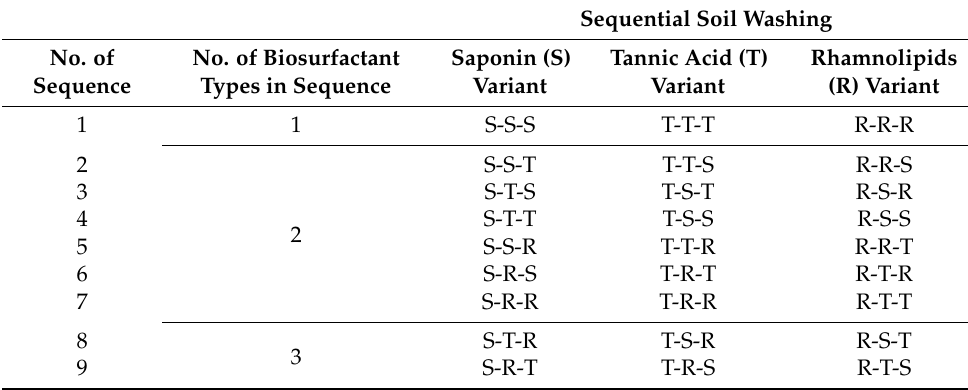
Table 3. Sequences of biosurfactant solutions for triple soil washing of smelter contaminated